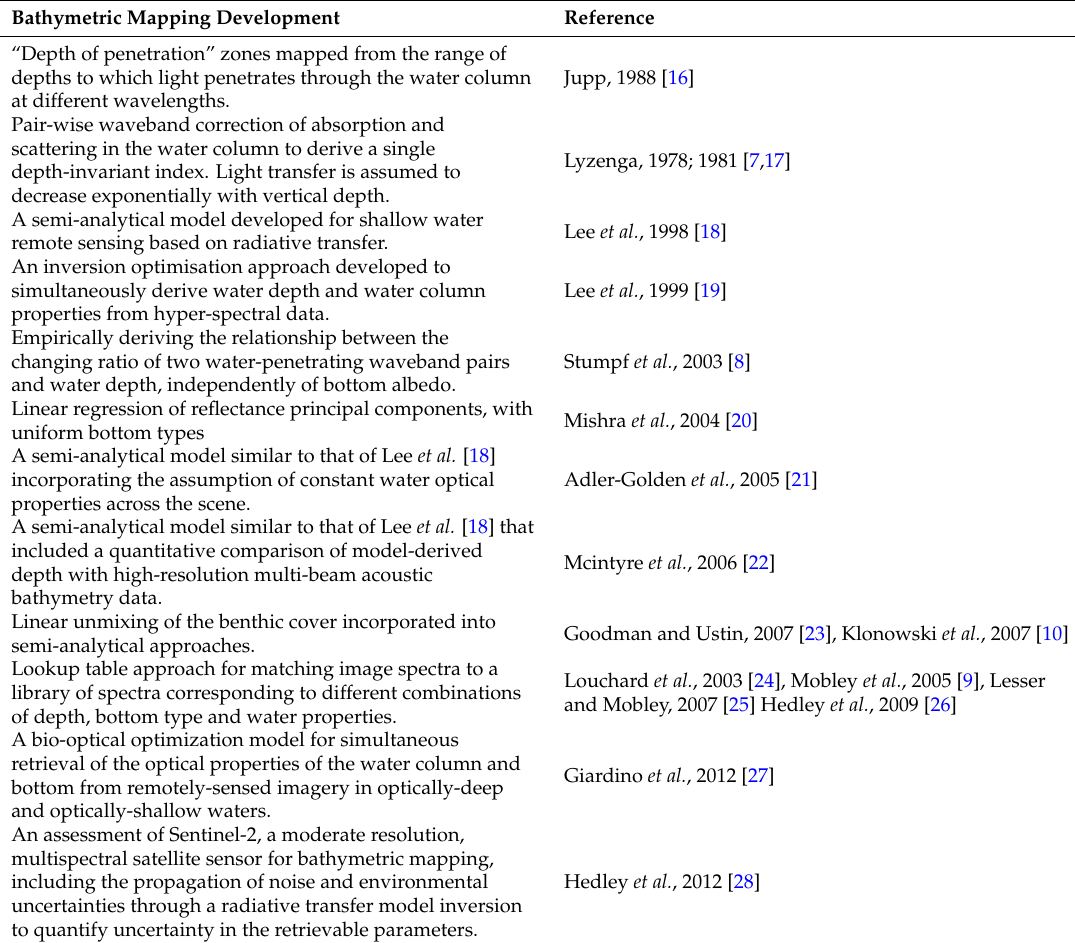
Table 1. Developments in the derivation of shallow water bathymetry from remote sensing